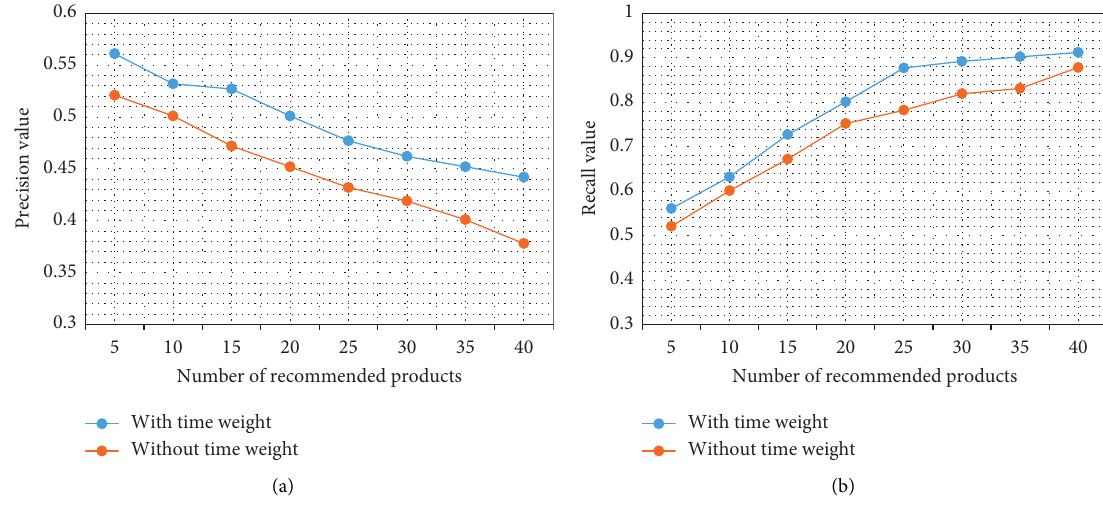
Figure 5: Result analysis of the recommendation algorithm with time weight and without time